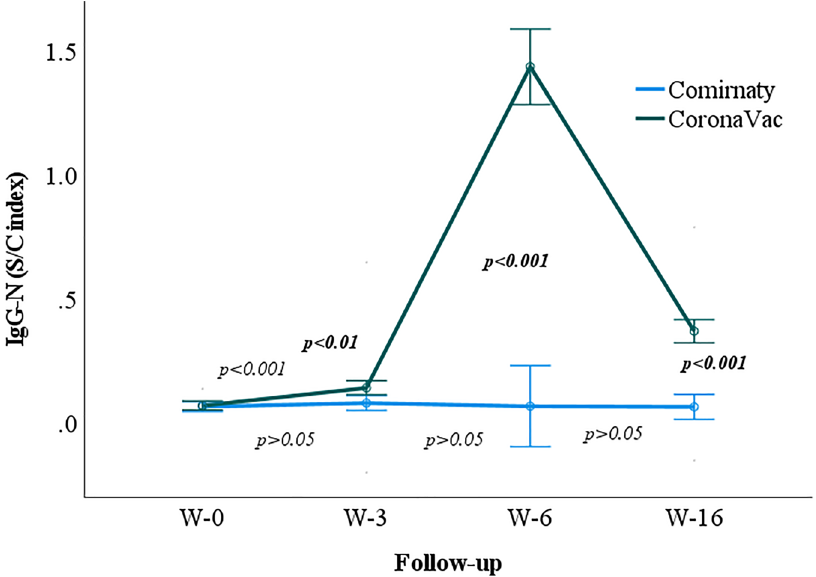
Figure 3. Geometric mean of the IgG-N S/C index in Comirnaty and CoronaVac vaccine recipients at weeks 0, 3, 6, and 16. W-0, Week zero; W-3, Week three; W-6, Week six, W-16, Week 16. Regular p value indicating the difference between two sampling points. Bolded p values indicating the difference between Comirnaty and CoronaVac at the respective week.